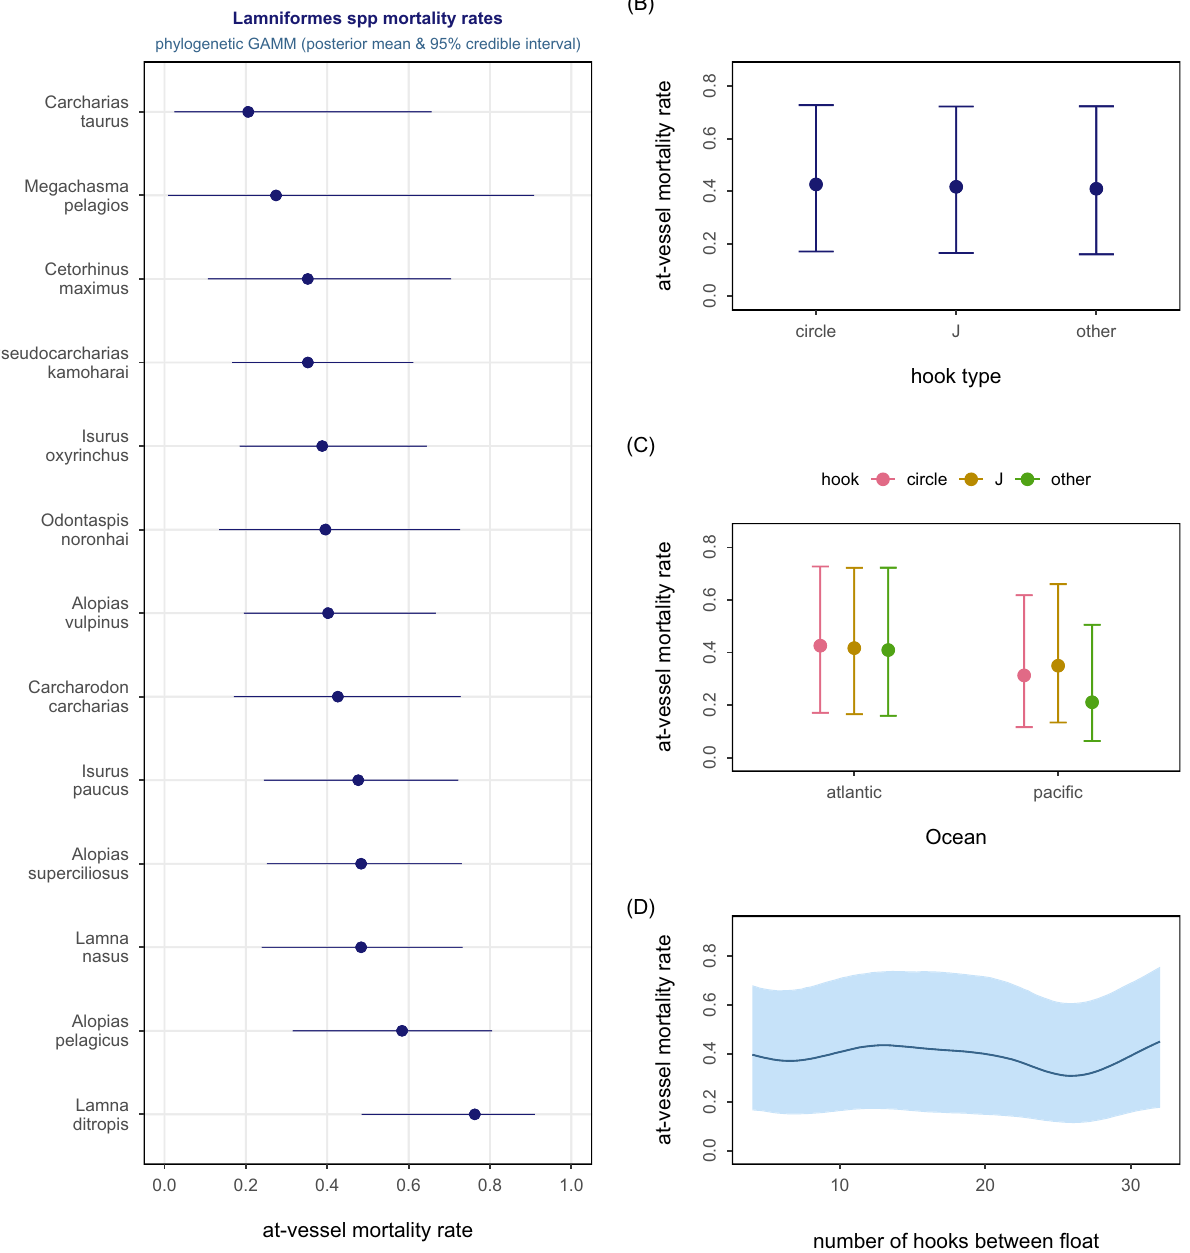
Figure 2. LAMNIFORMES. Graphical summary of the Bayesian phylogenetic meta-regression model (binomial-Normal GAMM) fitted to 466 AVM effect sizes compiled for this 13 shark species clade. Panel ( A ) shows the estimated conditional species-specific AVM rate arranged from lowest to highest rate. Panel ( B ) shows the estimated conditional hook shape effect on AVM. Panel ( C ) shows the estimated conditional effect of hook type within ocean basin effect on AVM. Panel ( D ) shows the estimated conditional effect of number of hooks between floats on AVM. Solid dot = posterior mean, horizontal or vertical bar = 95% credible interval, solid curve = mean nonlinear trend, shaded polygon = 95% pointwise credible